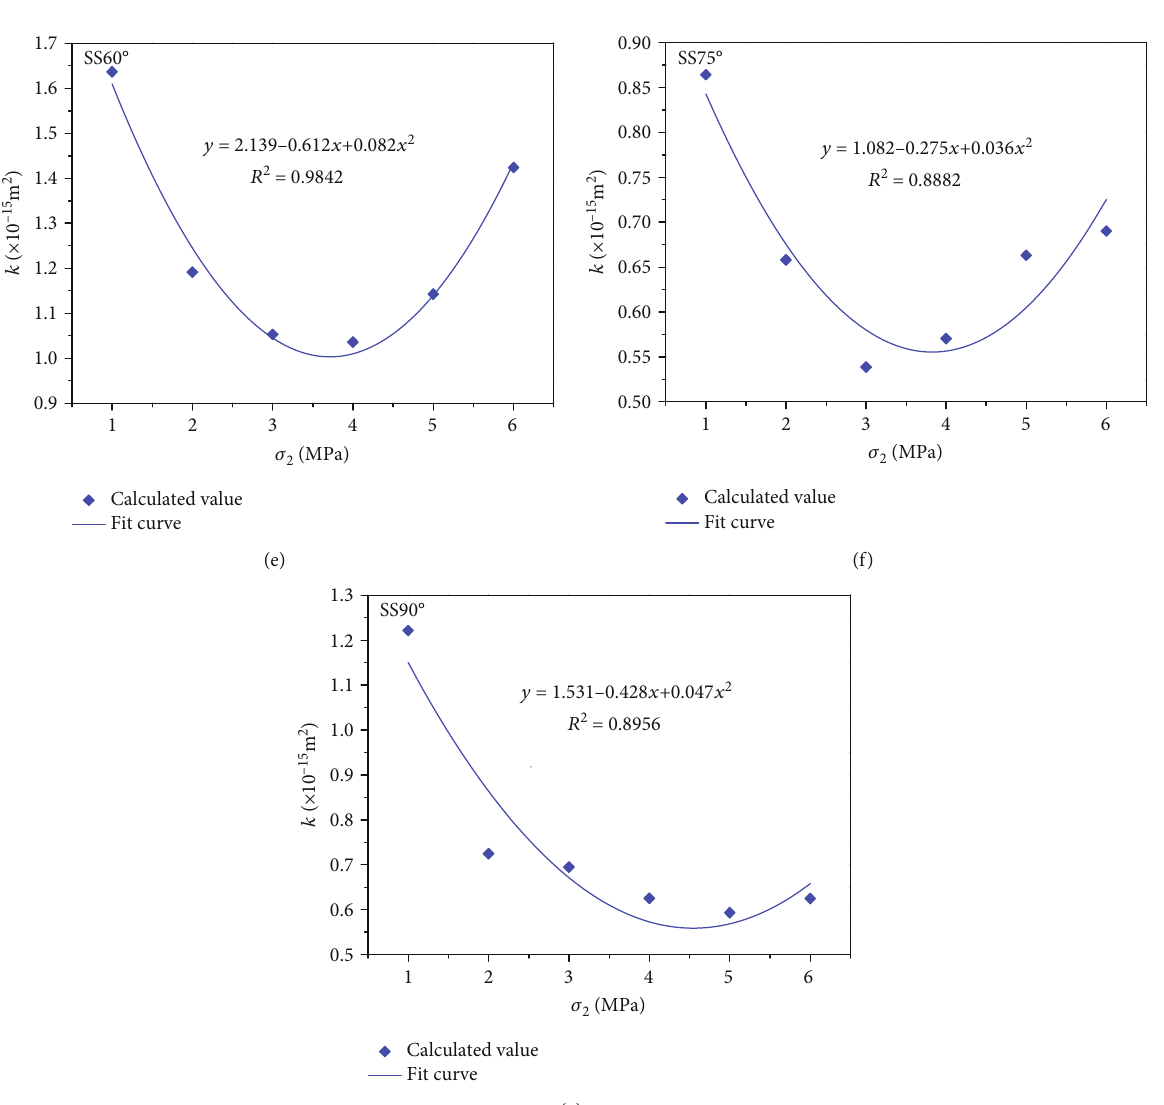
Figure 7: Relationship between the intrinsic permeability k and the intermediate principal stress σ